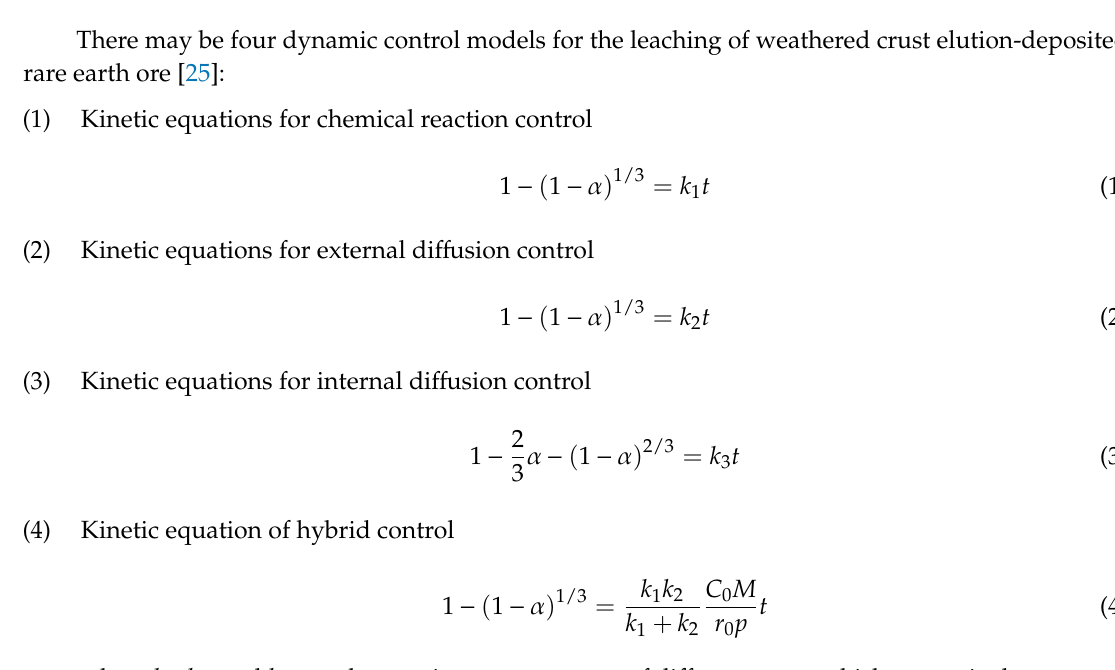
Figure 3. The schematic diagram of the RE leaching